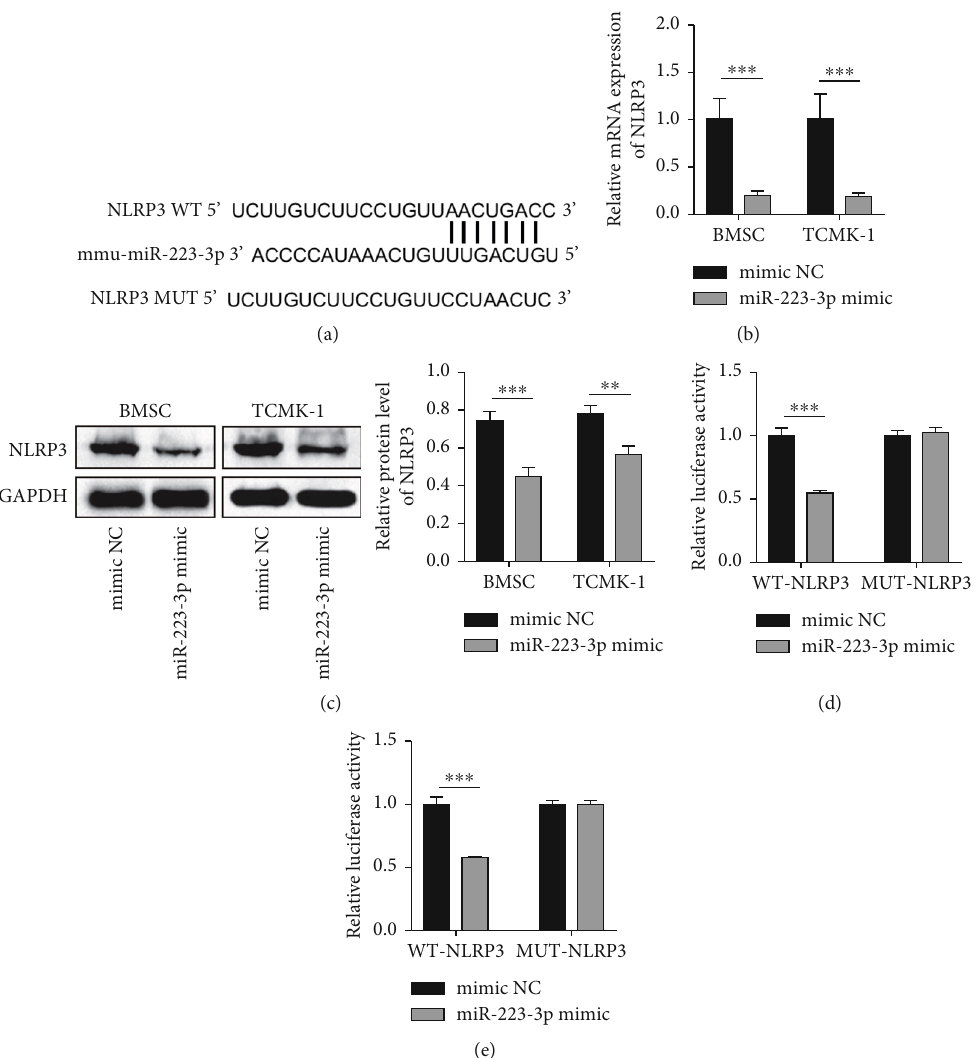
Figure 6: miR-223-3p targeted NLRP3. (a) A potential binding site of miR-223-3p is illustrated. (b and c) The expression of NLRP3 was determined at the mRNA and protein levels through qPCR and western blot analysis, respectively. (d and e) The dual-luciferase assay was used for validating the direct binding of miR-223-3p to NLRP3. N = 3 . ∗ P < 0 : 05 ; ∗∗ P < 0 : 01 ; ∗∗∗ P < 0 : 001